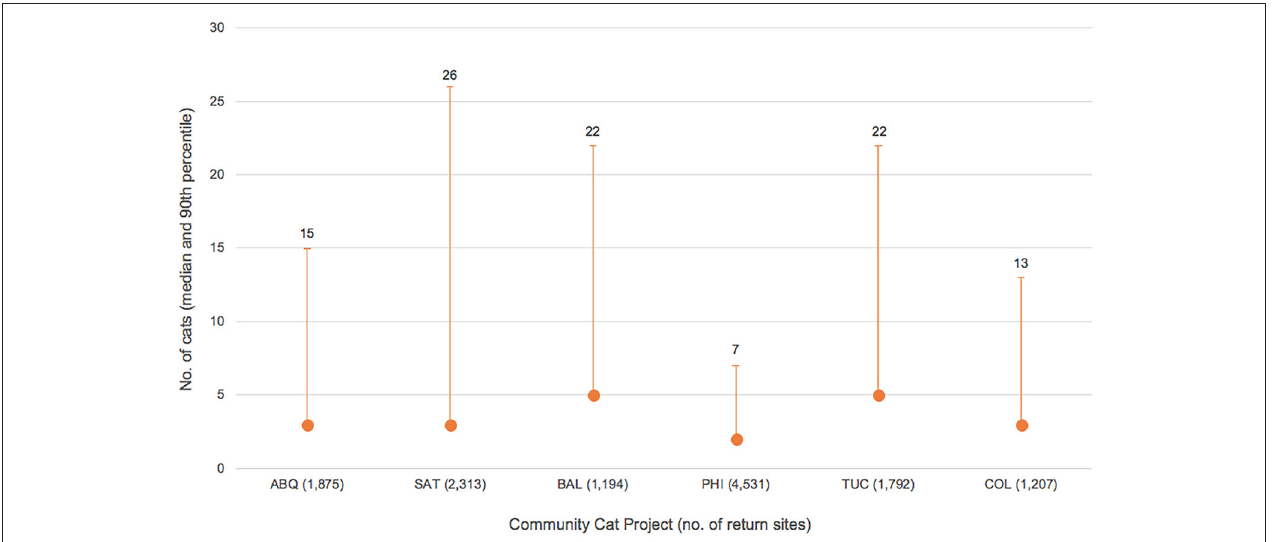
FIGURE 2 | Number of cats corresponding to source/return sites across six CCPs, with median figures (shown as solid dots) giving an approximation of median colony